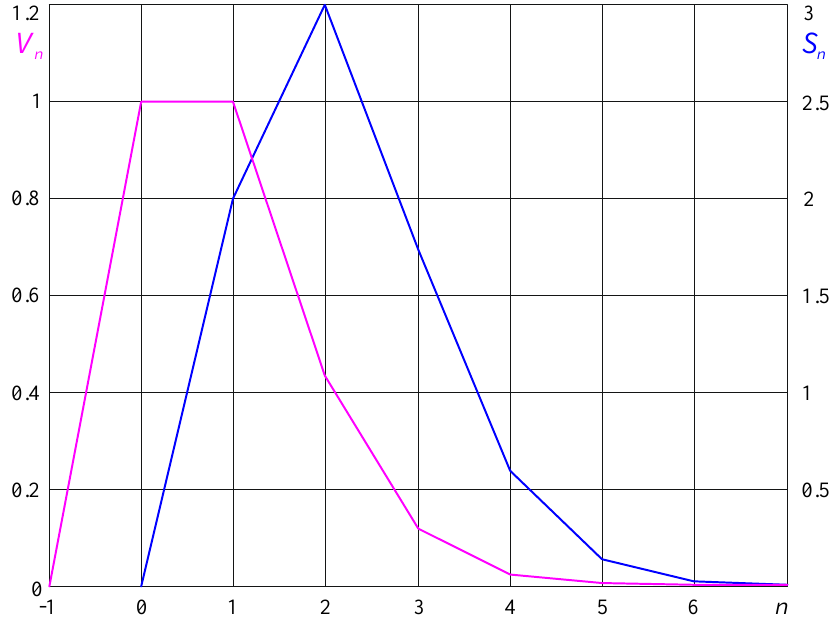
Figure 5. Graphs of volumes ( V ) and surface areas ( S ) of regular n -simplices of unit edge length for n = − 1, …,7.